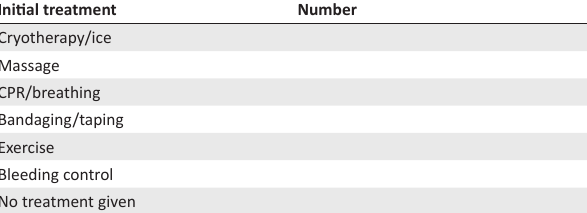
Individual fall Goal post fall Interference of fans Tackling a(cid:143)empts Accidental contact Others